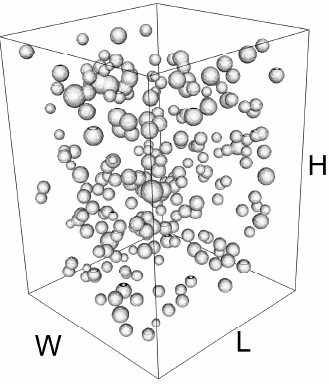
Figure A2. SEM pattern of the etched sample surface ( a ), probability density function of pore size distribution ( b ).